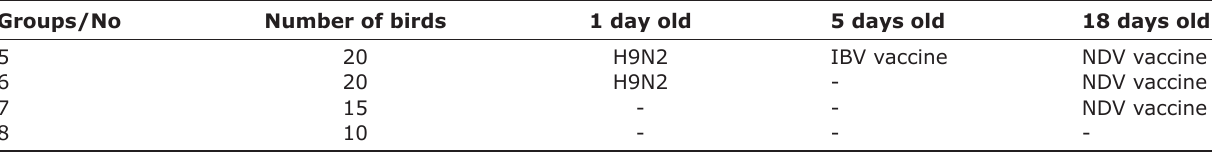
Table-2: The different treatment used in experiment 2.